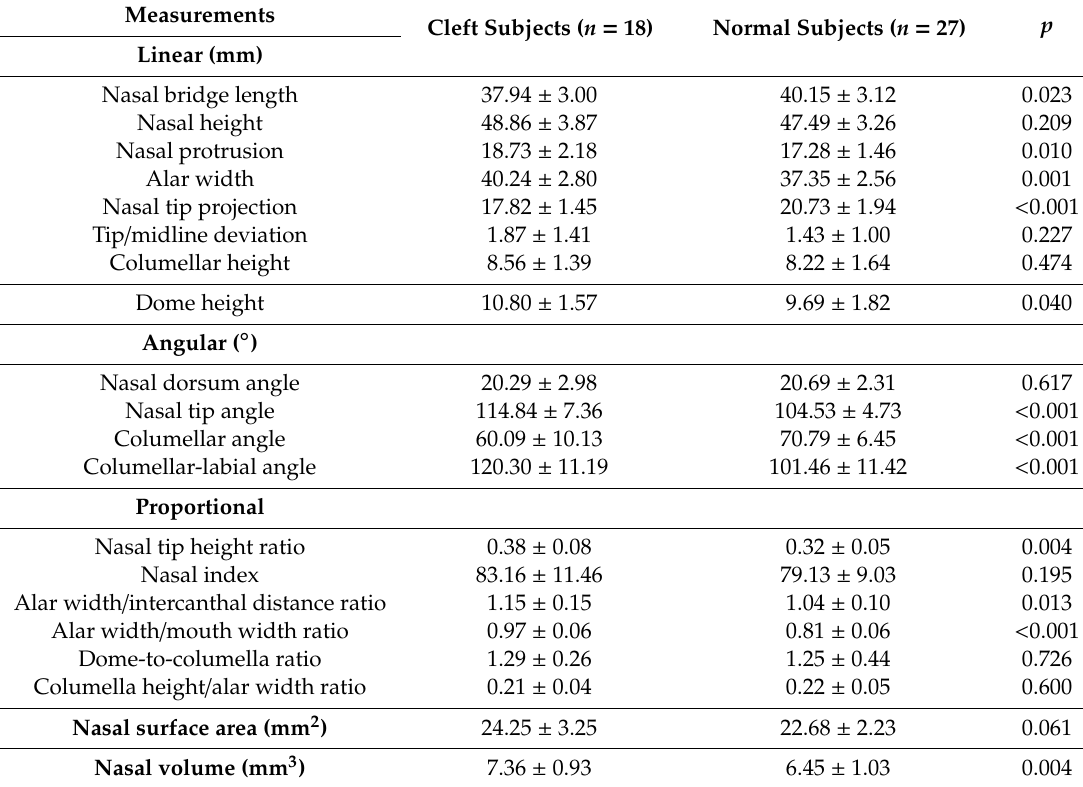
Table 6. Intergroup comparative analysis for female